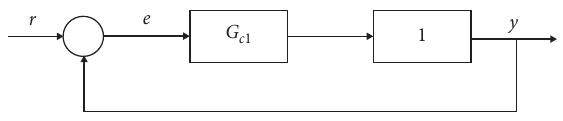
Figure 3: U-model-based simplified control